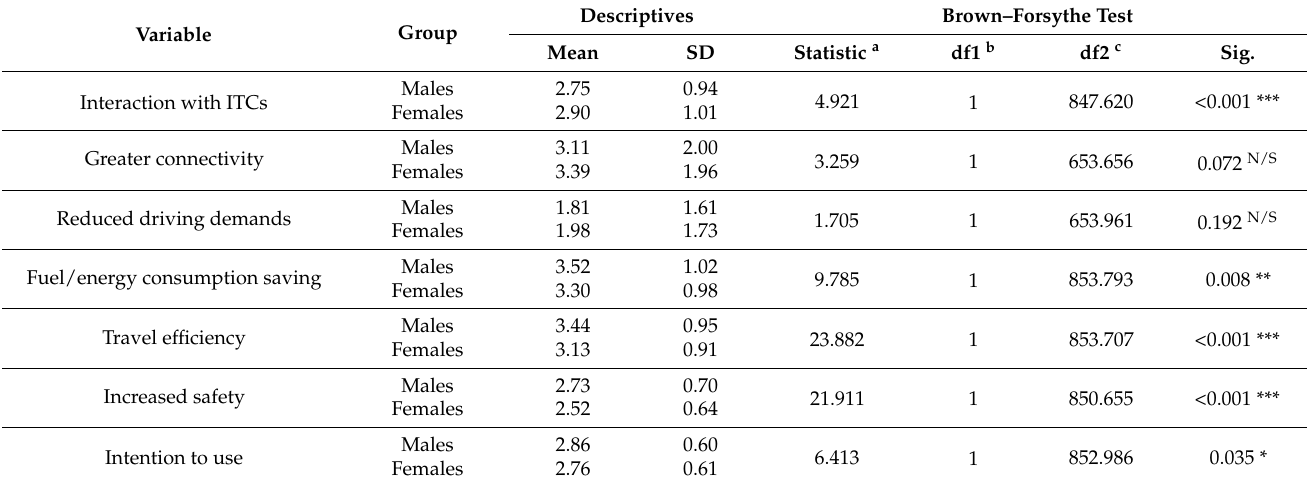
Table 3. Descriptive statistics and mean comparisons by driver’s gender.